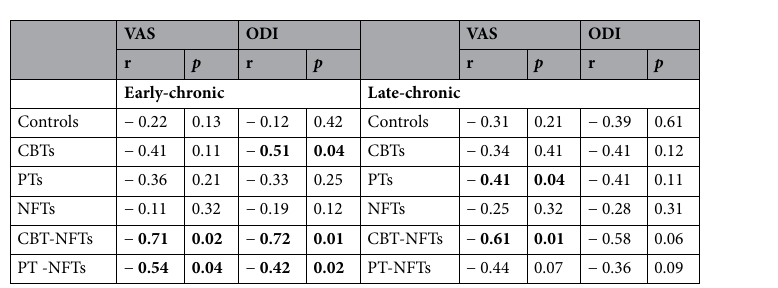
Table 5. Correlation coefficient about mean of nAP and VAS/ODI score in each group. Significant values are in [bold].